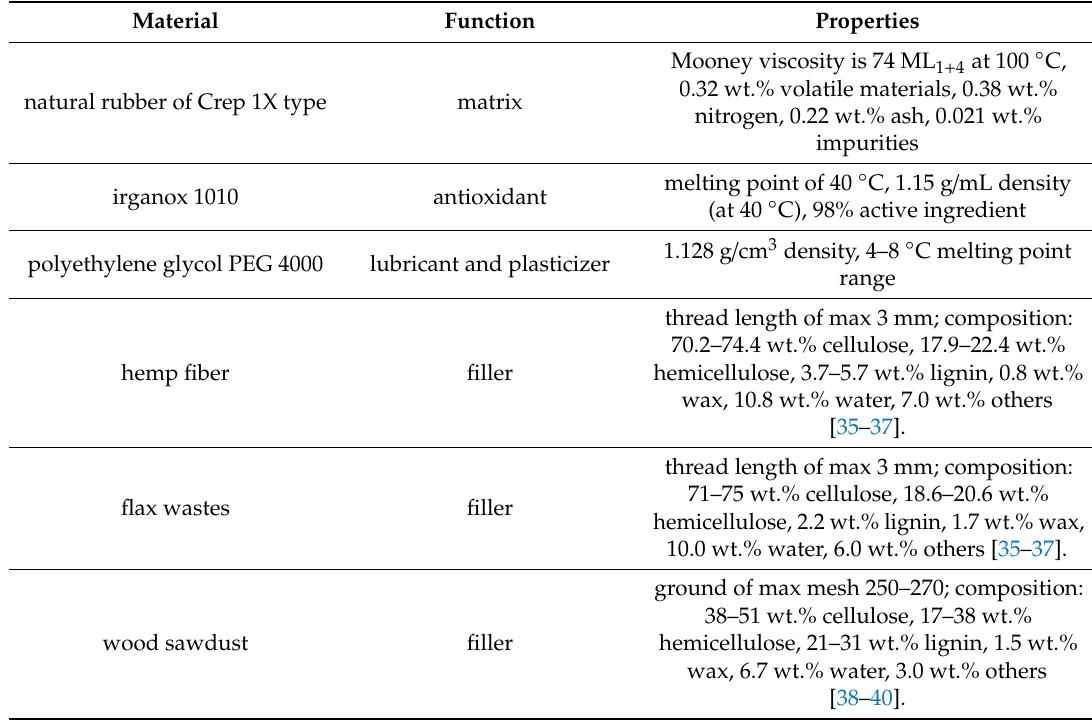
Table 1. The properties of materials used in experiments.